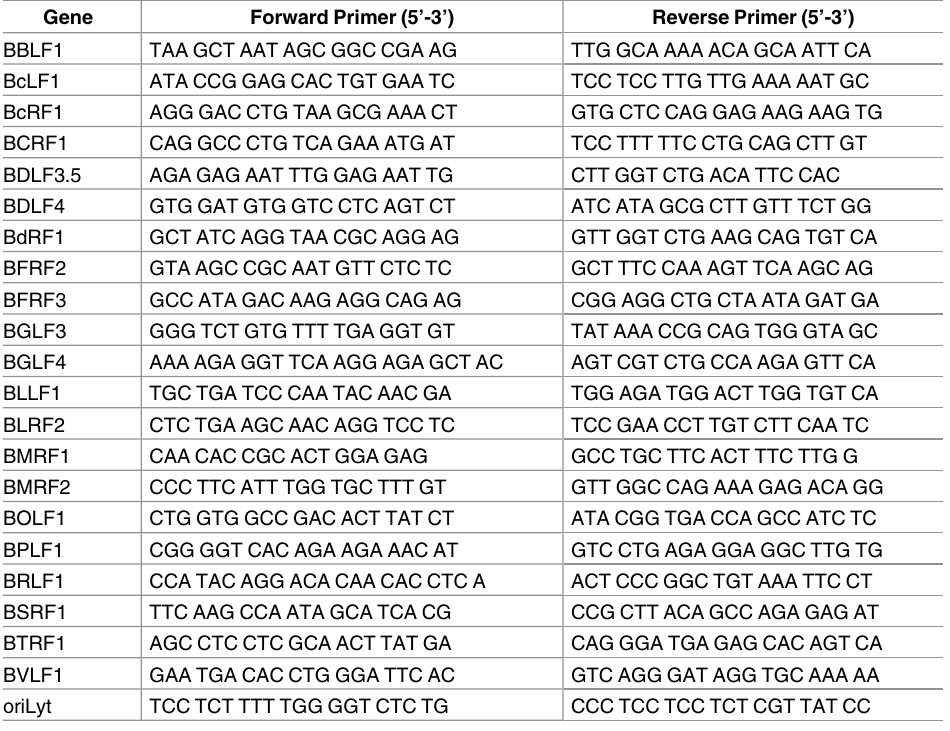
Table 3. Sequences of Primers used in real time PCR